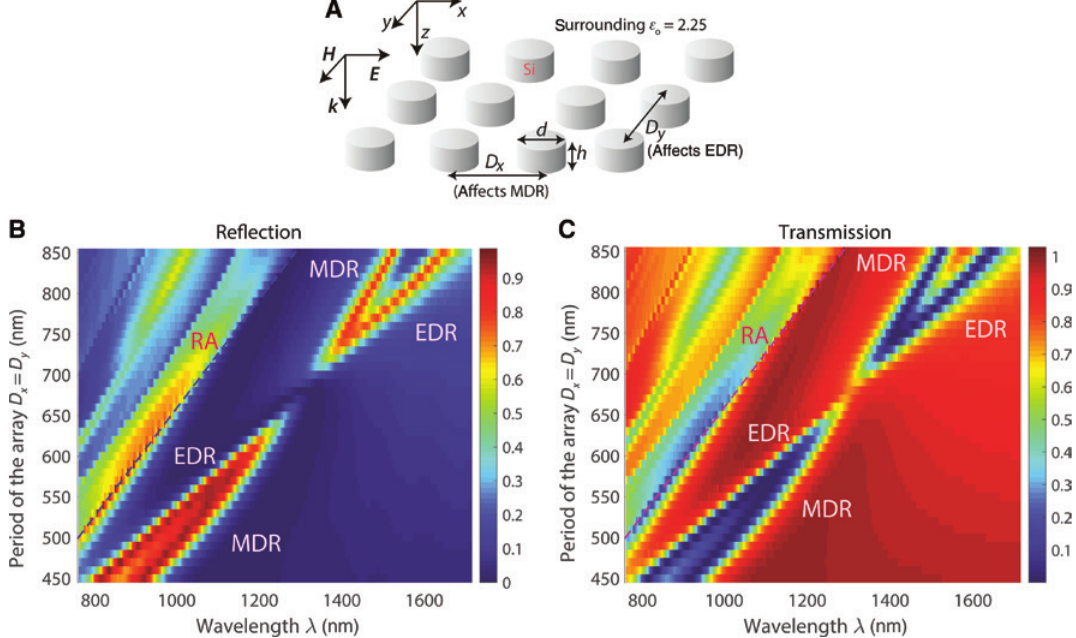
Figure 1: Overlap of electric and magnetic dipole resonances in the square disk array. (A) Schematics of the structure under consideration: periodic array of disks and normal incidence of the light with the E field along the x -axis. The surrounding medium has ε dipole resonance (MDR), and the period in the y -direction D through the disk array under variation of the array periods and disk diameters with D the Rayleigh anomaly wavelength λ